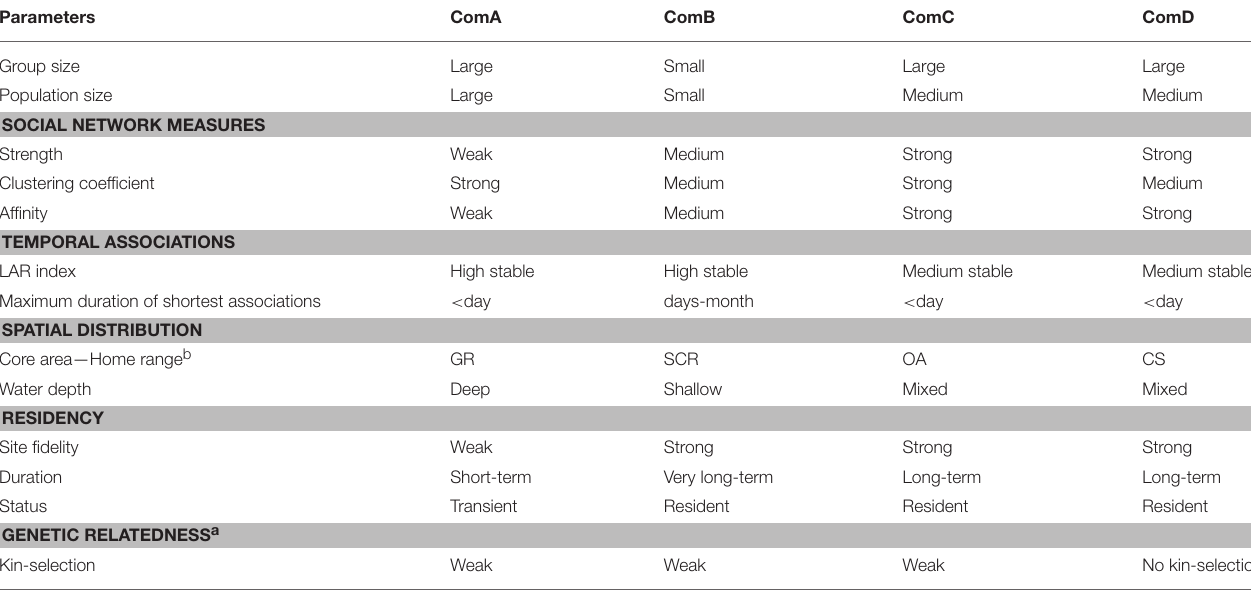
TABLE 8 | Summary comparison of social, temporal, spatial, residency, and genetic patterns across the four communities (ComA, ComB, ComC, and ComD).